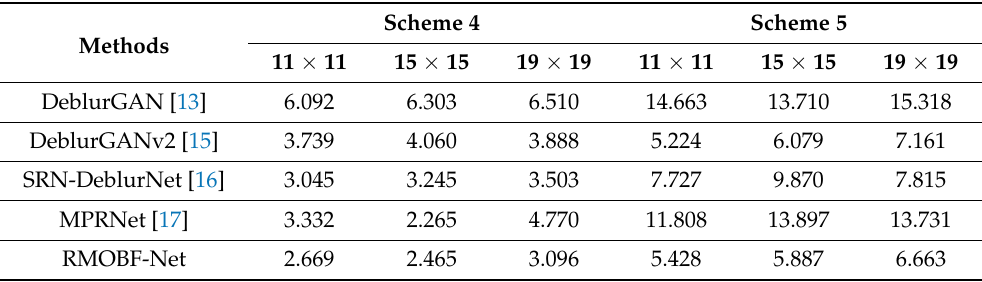
Table 9. Comparisons of finger-vein recognition error (EER) on PolyU-DB by schemes 4 and 5 with state-of-the-art restoration models and proposed RMOBF-Net (unit: %).